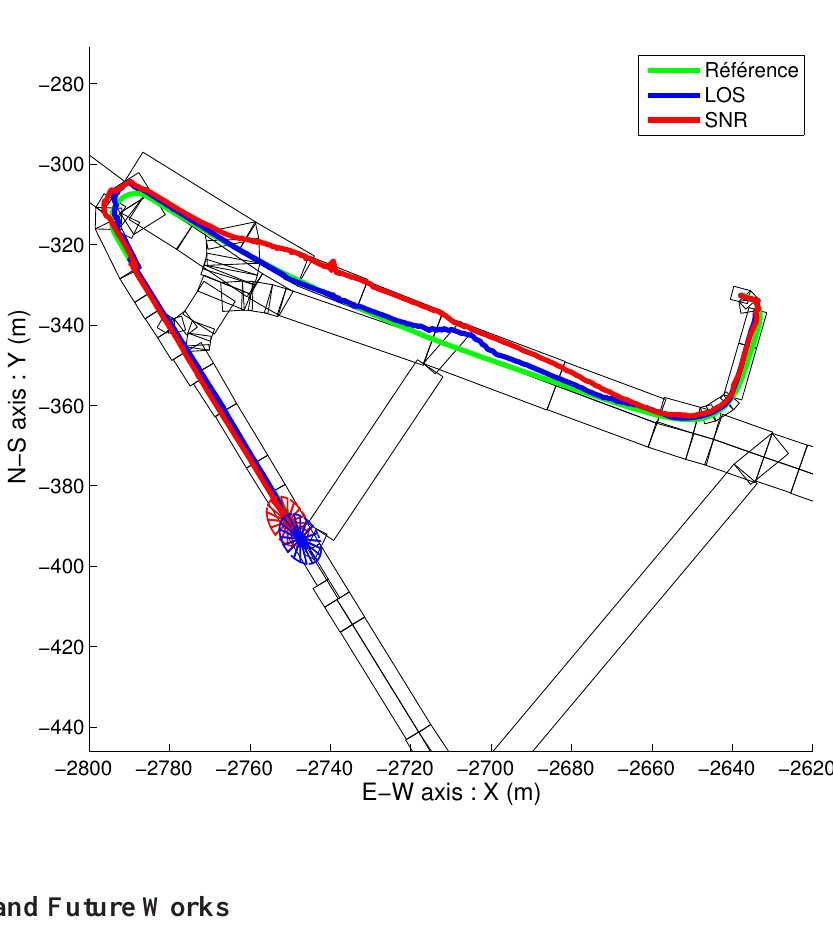
Figure 15. 2D overview of map-aided solutions for both strategies. Simplified